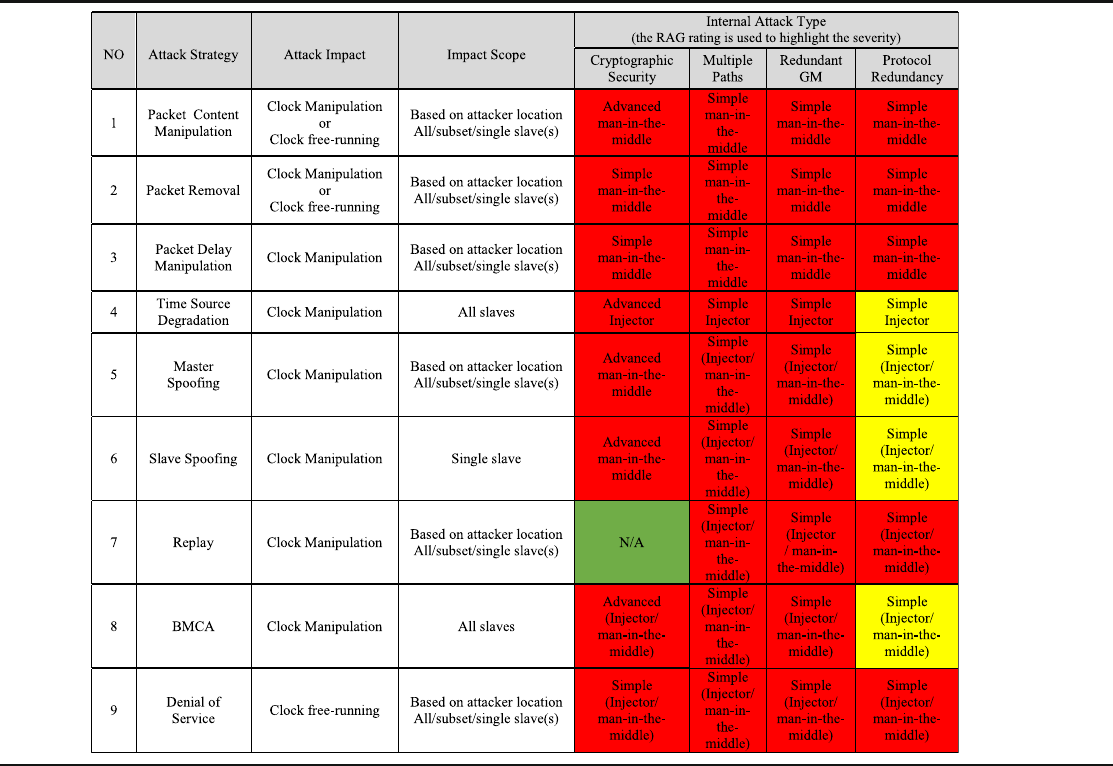
Table 2 PTP Attack Strategies and their